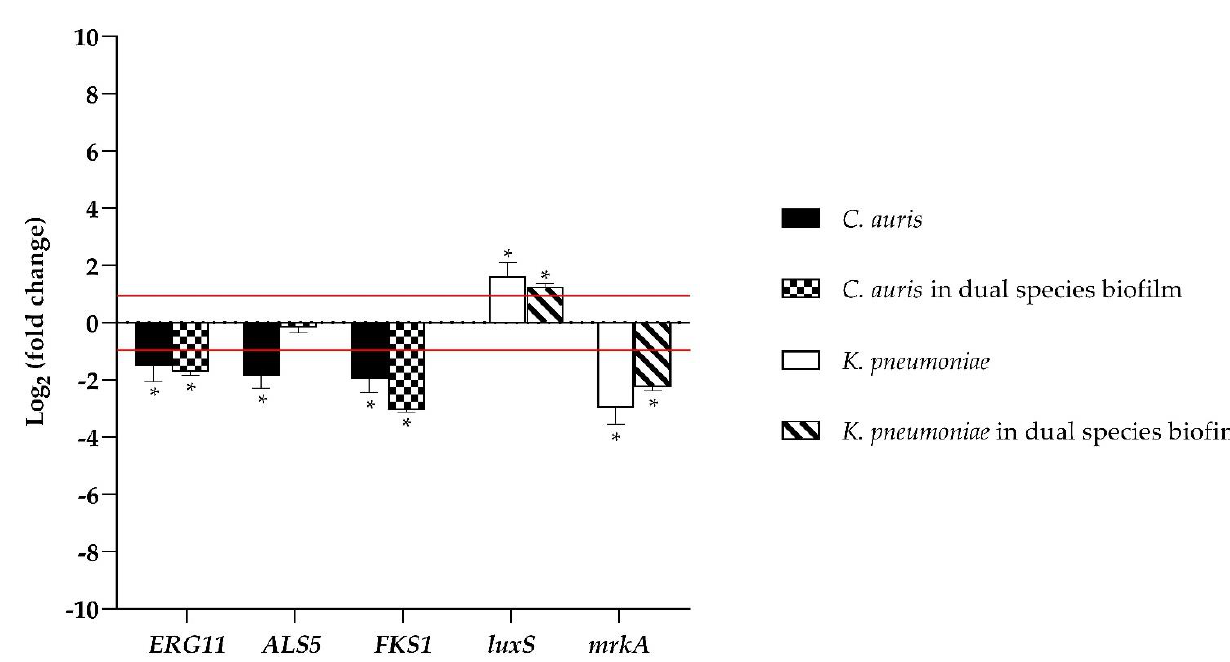
Figure 4. Real-time qPCR at 24 h of treatment with MYR at a concentration of 12.5 µ gmL − 1 . Histograms show the mean ± SD of relative mRNA expression levels of virulence response genes. Horizontal red lines indicate fold change thresholds of 2 and 0.5, respectively. * = p < 0.05 ( t -test).